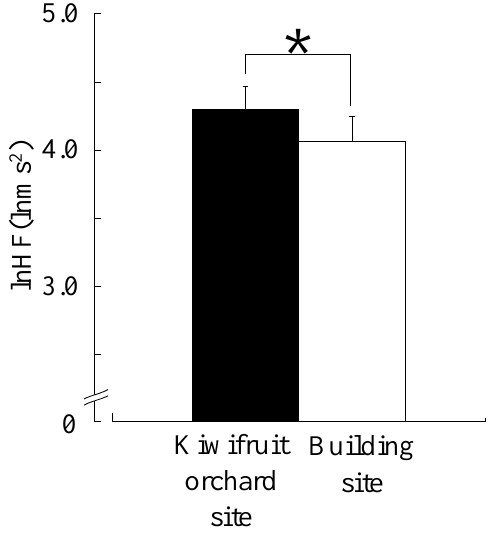
Figure 3. Comparison of the natural logarithmic value of high-frequency (HF) power levels of the heart rate variability during 10-min viewing of a kiwifruit orchard or a building site. Data are expressed as the means ± standard error (SE); n = 17. * p < 0.05 by the paired t -test